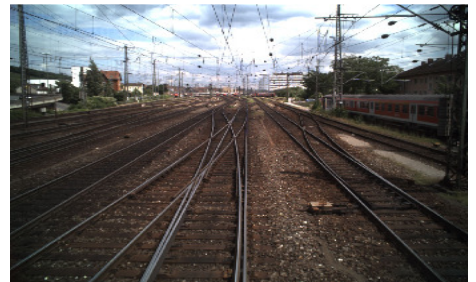
Figure 7. A typical site of Deutsche Bahn system (source: Christophe Leimkühler, Metronom Software)